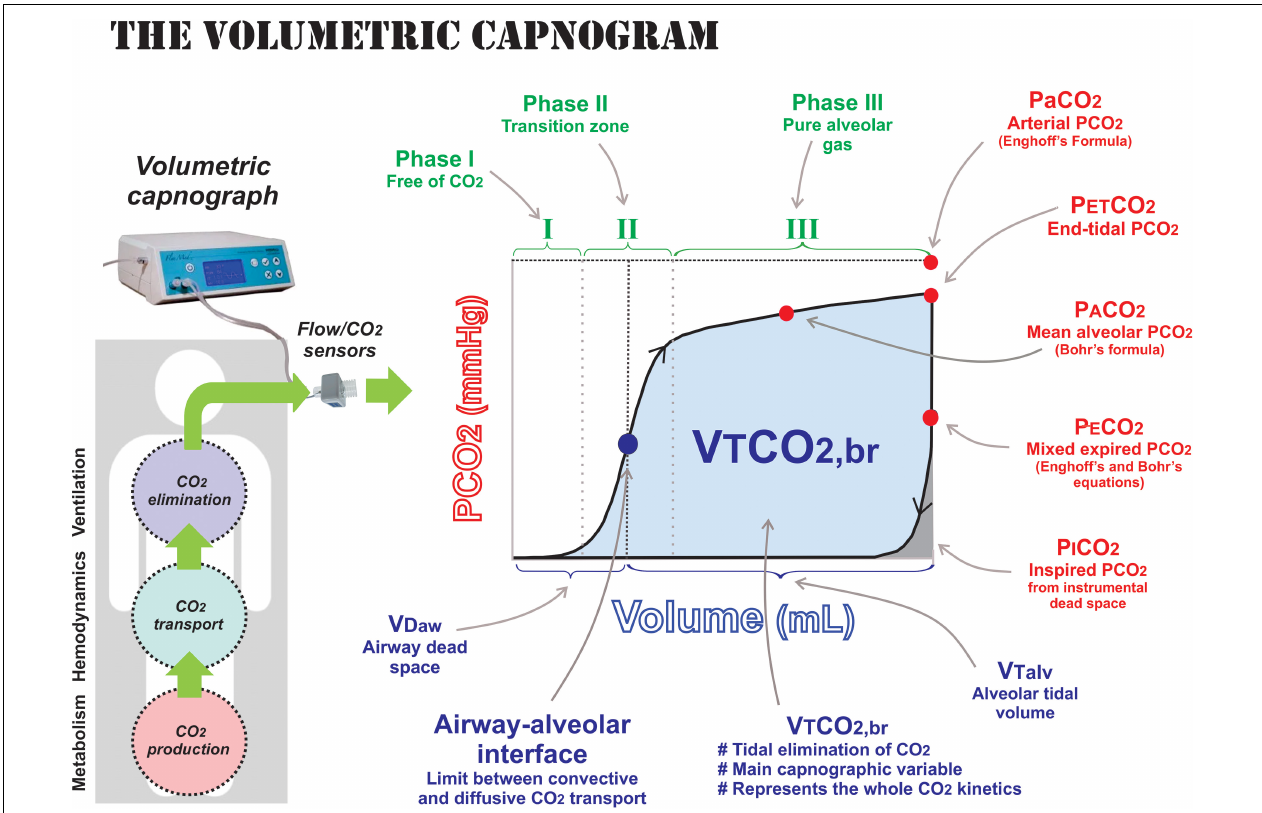
FIGURE 1 | Components of volumetric capnography. The volumetric capnogram is the plot of expired CO 2 in one tidal breath measured by mainstream flow and CO 2 sensors. The capnogram phases are shown in green: phase I is the portion of the expired gas without CO 2 that represents pure airway dead space; phase II is the transition zone composed by the progressive emptying of lung units with different time-constants and spatial distribution; and phase III is the pure alveolar gas expired once airway dead space (VD aw ) has been washed out. The relevant partial pressures of CO 2 measured by VCap are presented in red: end-tidal (PETCO 2 ), mean alveolar (PACO 2 ), mixed expired (PECO 2 ), and inspired (PICO 2 ) pressure. The arterial PaCO 2 is not directly measured, but it included for referencing of the other partial pressures. The volumes obtained by the VCap are presented in blue: volume of airway dead space (VD aw ), alveolar tidal volume (VT alv ), and volume of CO 2 eliminated per breath or area under the VCap curve (VTCO 2 , br ). The blue dot represents the airway–alveolar interface, the limit between convective and diffusive CO 2 transport close to the entrance of lung acini and, therefore, it also morphologically separates the conducting from the gas-exchanging lung